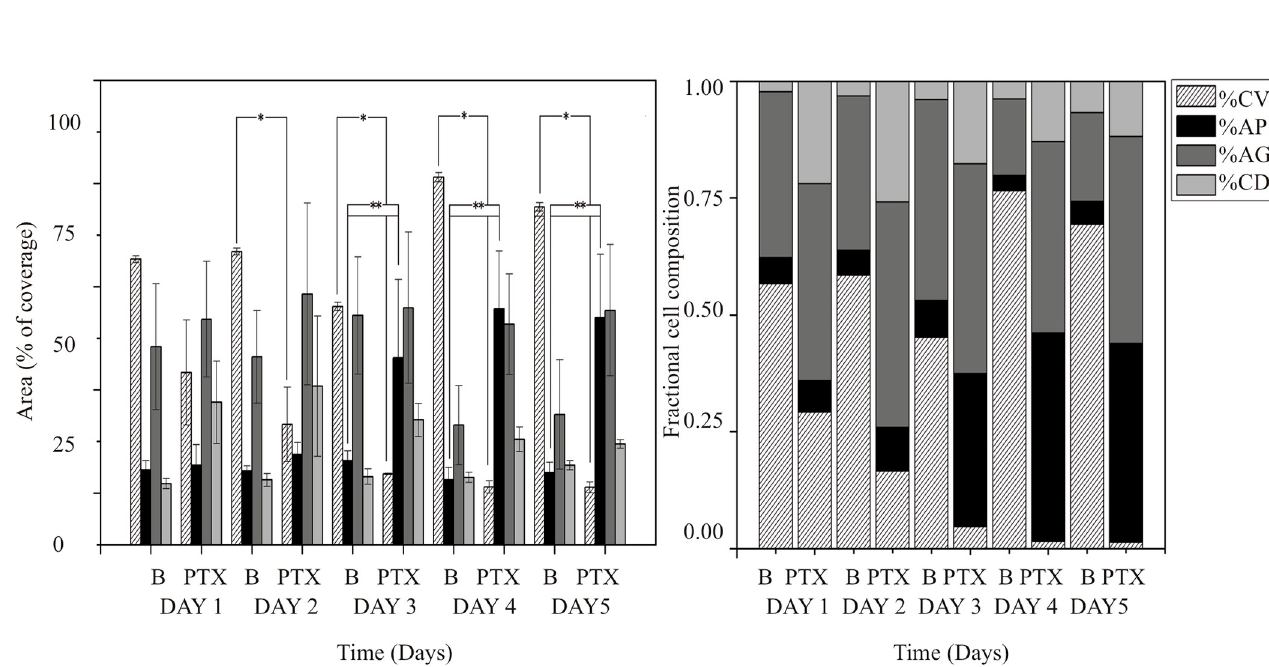
Fig 6. Paclitaxel (PTX) effect compared with control (B) over 5 days at low PTX concentration. Bar graph denotes the value of percentage of the area covered by cells for each of the studied cell death modes. Left, the apoptosis process ( AP ) increased significantly in comparison to the control, and the area coved by viable cells ( CV ) decreased significantly with respect to the control. Right, stacked bar graph shows the value of the results in cell fraction composition per day for a period of five days. ( �� ) and ( � ) indicates significant difference between days among subgroups (p < 0.05).